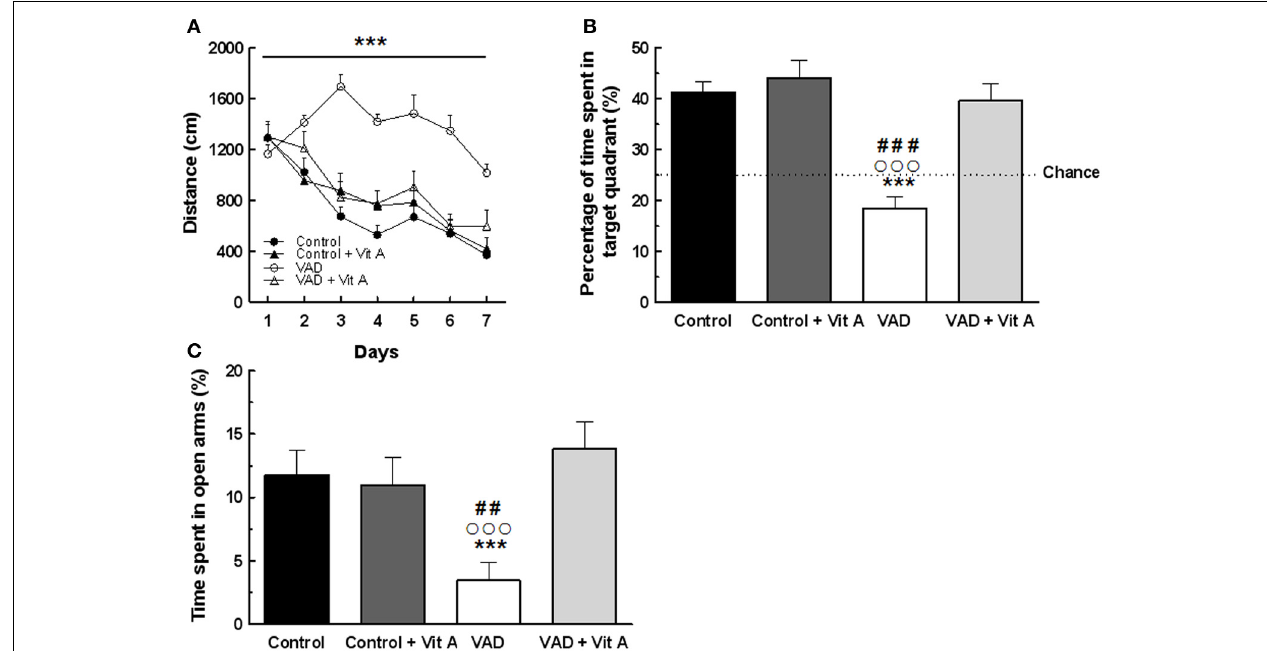
FIGURE 3 | Effects of 14 weeks of VAD and vitamin A supplementation on (A, B) spatial learning and memory and (C) anxiety-like behavior. (A) Distance covered to reach the hidden platform over the 7 consecutive days of spatial learning (spatial learning; blocks of trials for each training day are averaged). (B) Percentage of time spent by rats in the target quadrant (Probe test). The dotted line corresponds to chance level (25%). VAD rats exhibit longer distance compared to controls to reach the platform during acquisition and they spent a percentage